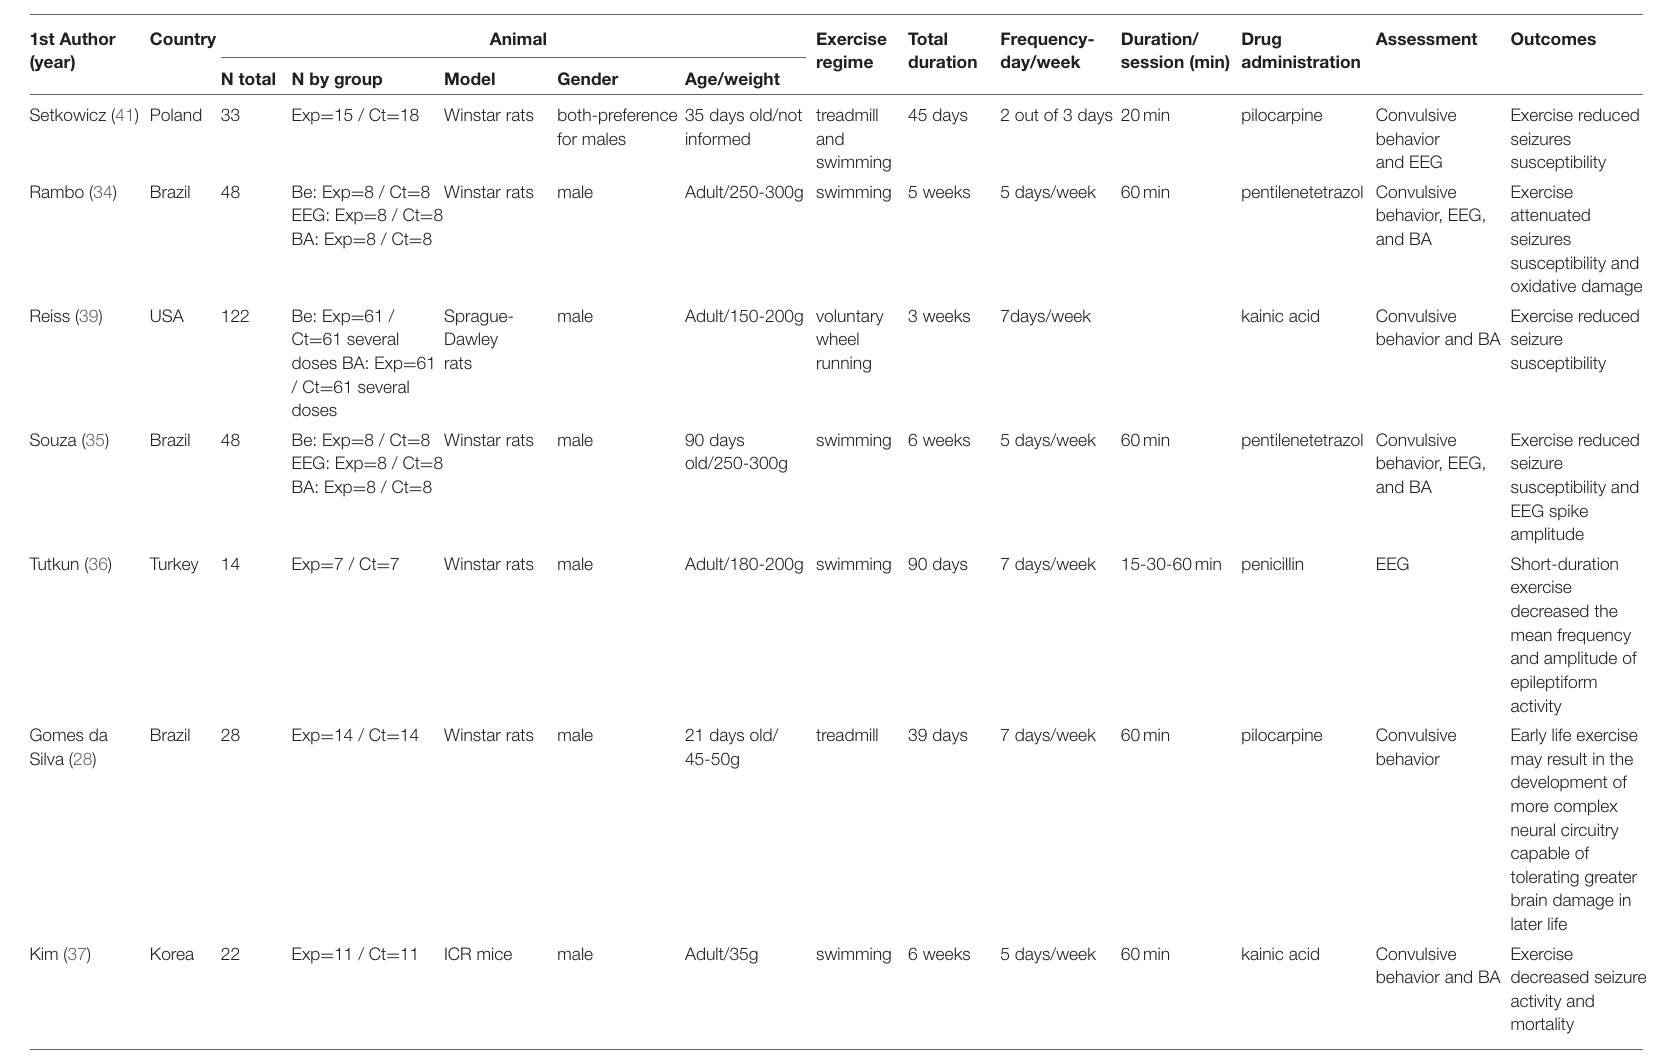
TABLE 1 | Summary of included study design, procedures and outcomes. Summary of study design, procedures and